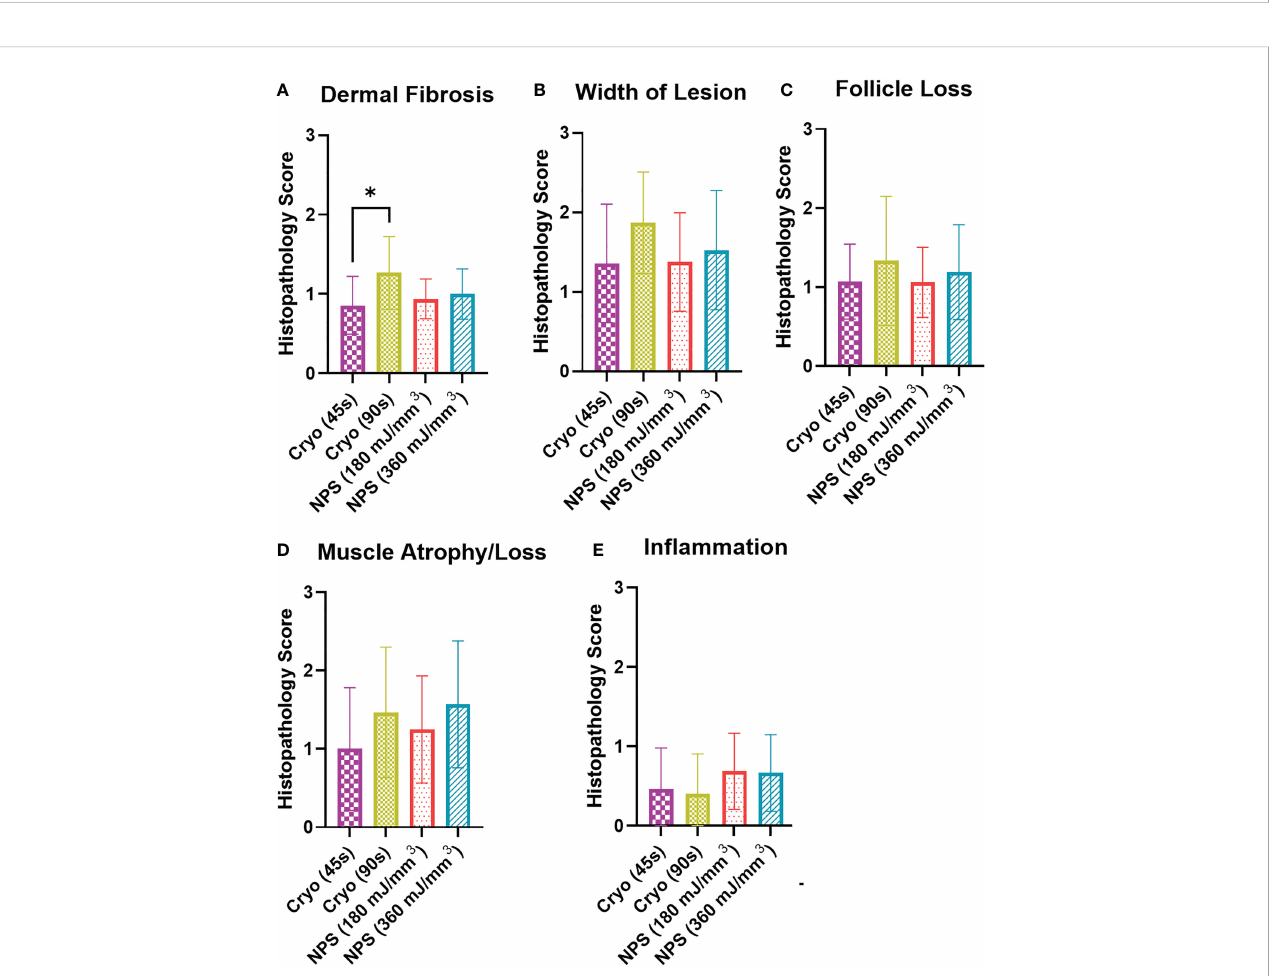
FIGURE 6 Histopathology scoring of histology sections collected on day 65 from each tumor treatment. Scale: 0=no lesion, 1=mild, 2=moderate, 3= marked. (A) Dermal fi brosis was signi fi cantly higher for the 90s cryo treatment than the 45s treatment (Kruskal-Wallis ANOVA, *p<0.05); (B) Lesion width showed no signi fi cant differences between the different treatments; (C) Hair follicle loss was similar for all treatments; (D) Muscle atrophy/loss: 1=partial loss; 2= full- thickness loss of muscle for short distance; 3=extension of atrophy beyond full-thickness loss. There was no signi fi cant difference in atrophy among the four treatments; (E) In fl ammation score indicated only very minor in fl ammation at 65 days for the four treatments.